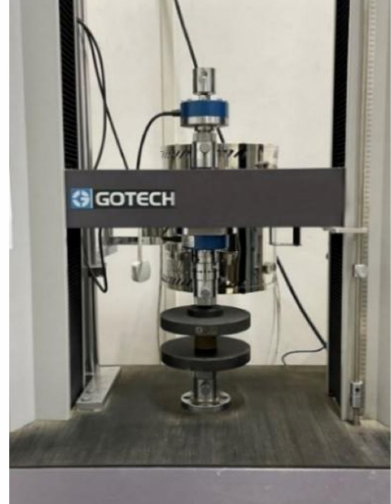
Figure 2. Unconfined compressive strength